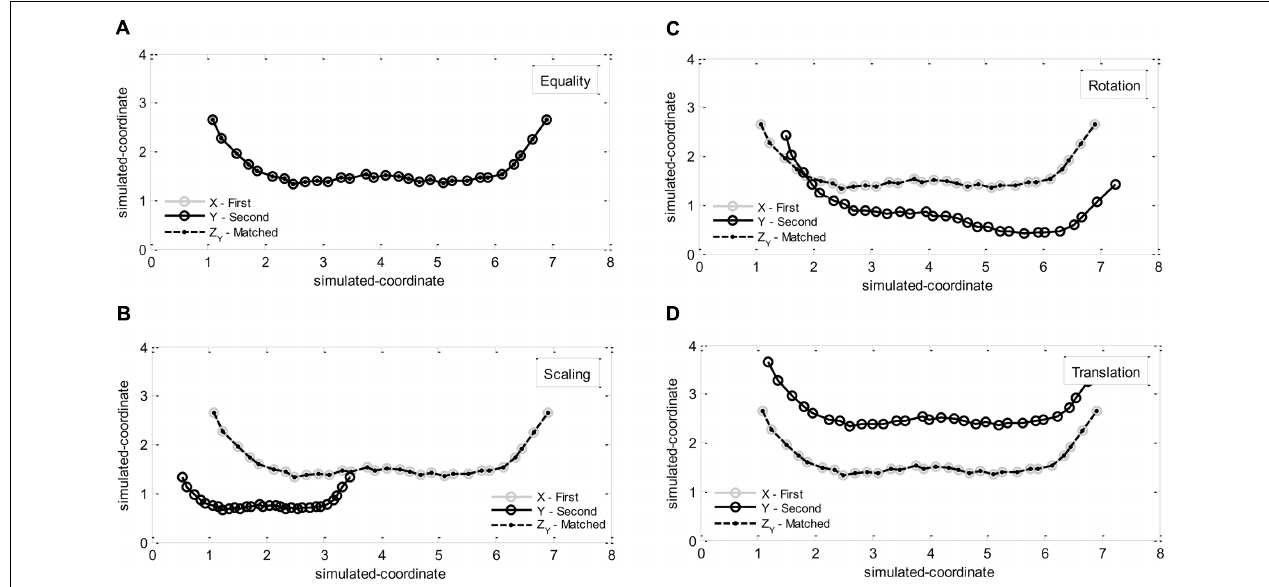
FIGURE 1 | Procrustes method for X and Y simulated shapes when shape Y is equal to: (A) shape X , (B) a scaled version of X (by 0.5), (C) a rotated version of X (by 10 ◦ ), (D) a translated version of X [by (0.1, 1.0)].